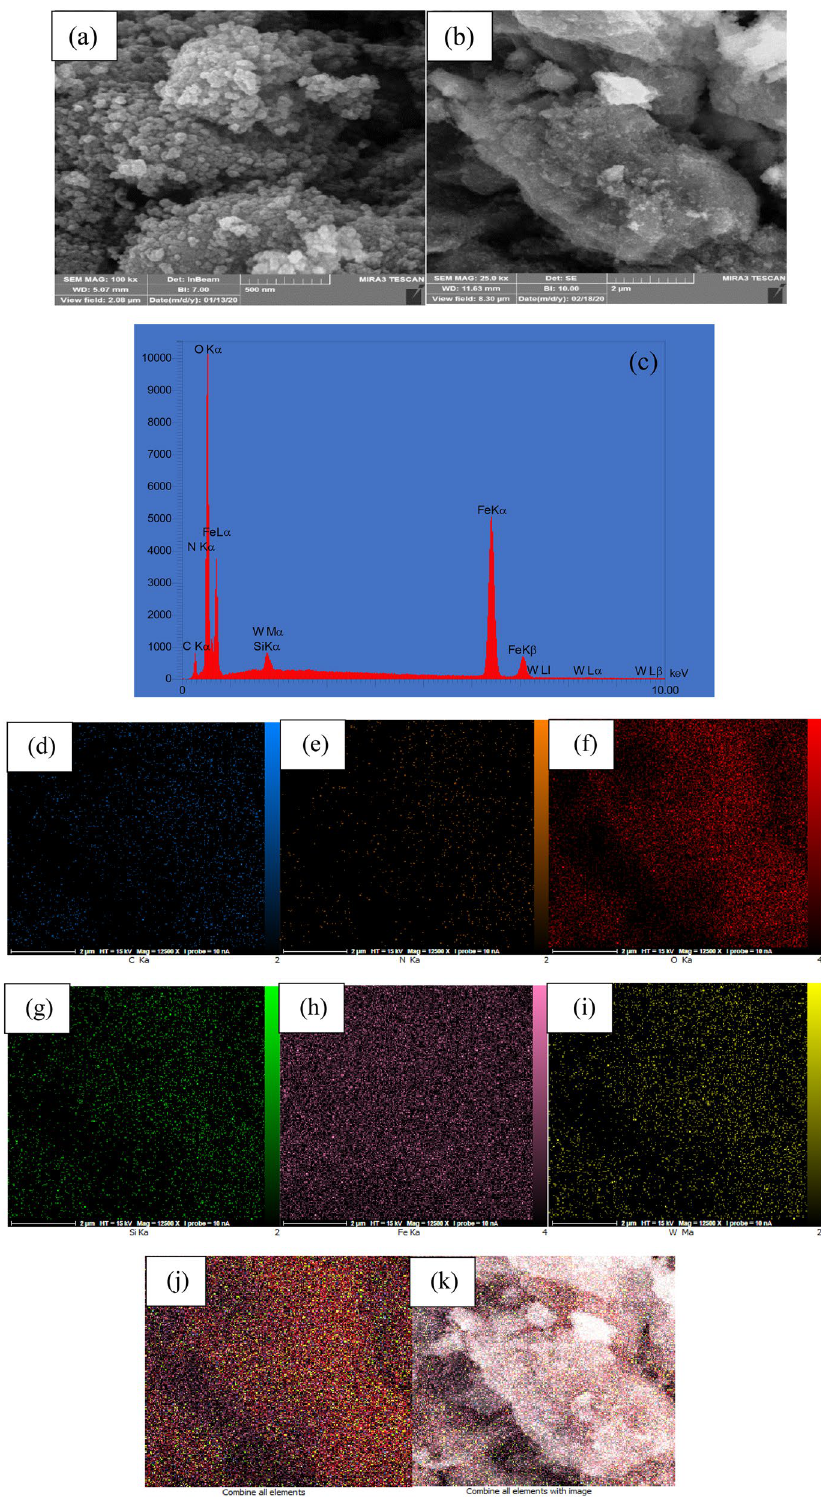
Figure 5. ( a , b ) FESEM images of (γ-Fe 2 O 3 -Im-Py) 2 WO 4 , ( c ) EDX spectrum and the corresponding quantitative EDS element mapping of ( d ) C, ( e ) N, ( f ) O, ( g ) Si, ( h ) Fe, ( i ) W and ( j , k ) all